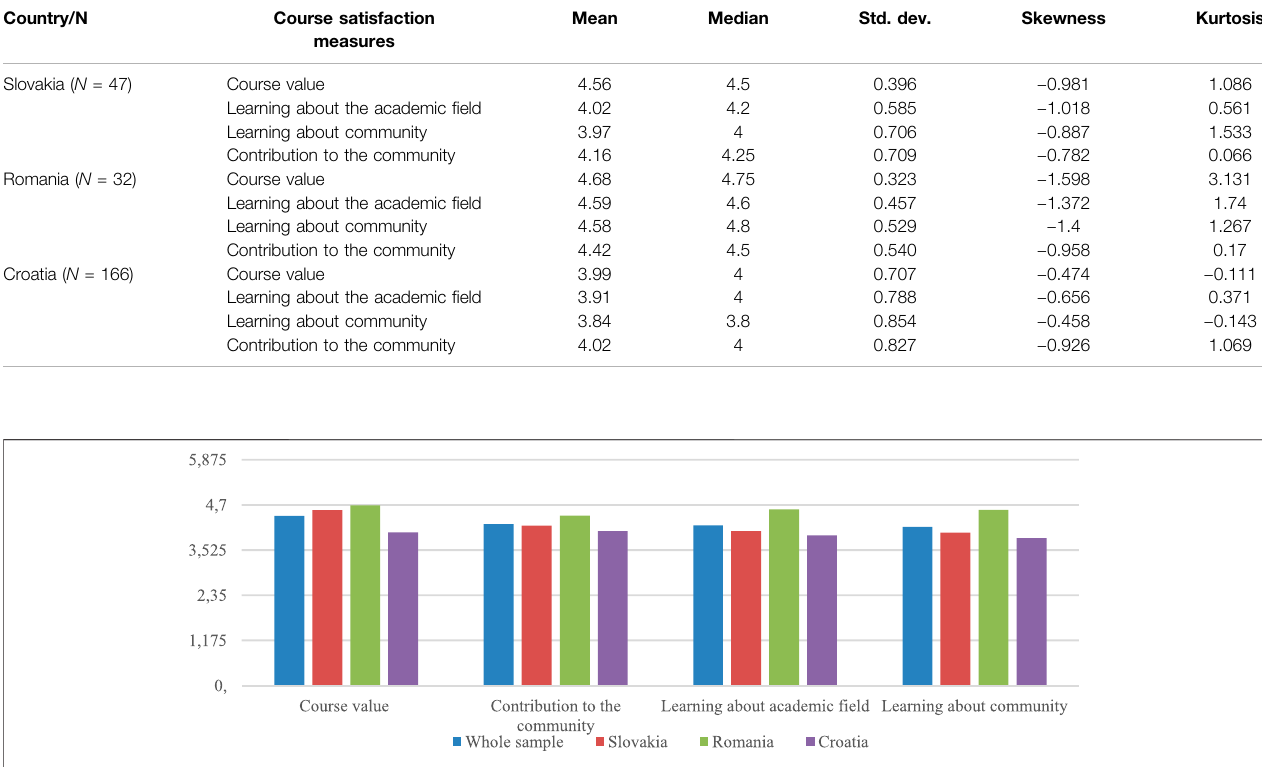
Learning about Contribution to the academic community community fi eld